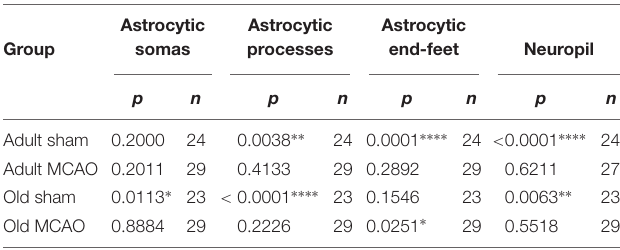
TABLE 3 | Mixed models linear regression analysis of the relationships between Ca 2 + responsivity in neuronal somas, neuropil, and astrocytes. Astrocytic